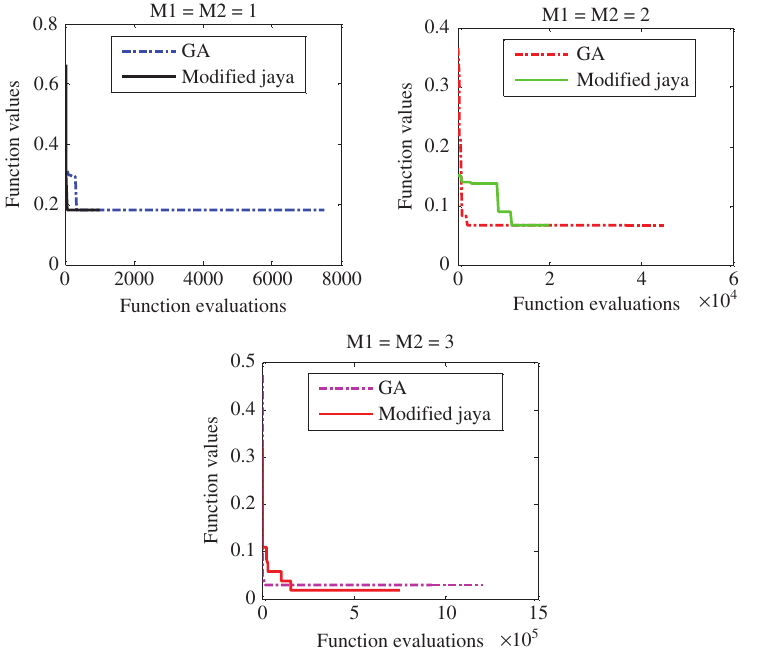
Figure 15: Convergence Rate of Best Objective Function Values in GA and Modified Jaya for the Number of Balance Masses for Case